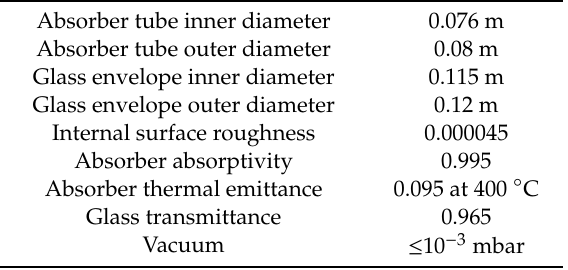
Table A2. Main parameters of the solar receiver (2008 PTR 70) [49].